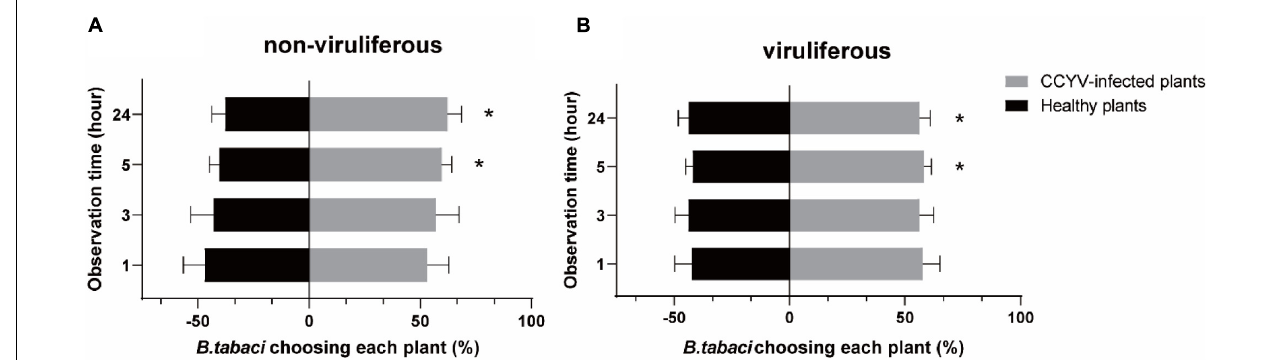
FIGURE 3 | Behavioral response of non-viruliferous (A) and viruliferous (B) B. tabaci to CCYV-infected and healthy plants. This experiment was conducted in an insect cage (60 × 60 × 60 cm), and B. tabaci adults were released in the center. “*” means p < 0.05. Percentage was transformed with arcsine before difference analysis. The one-sample t -test was used to analyze the difference ( p < 0.05). The difference between the percentage and the hypothesis of 50%.